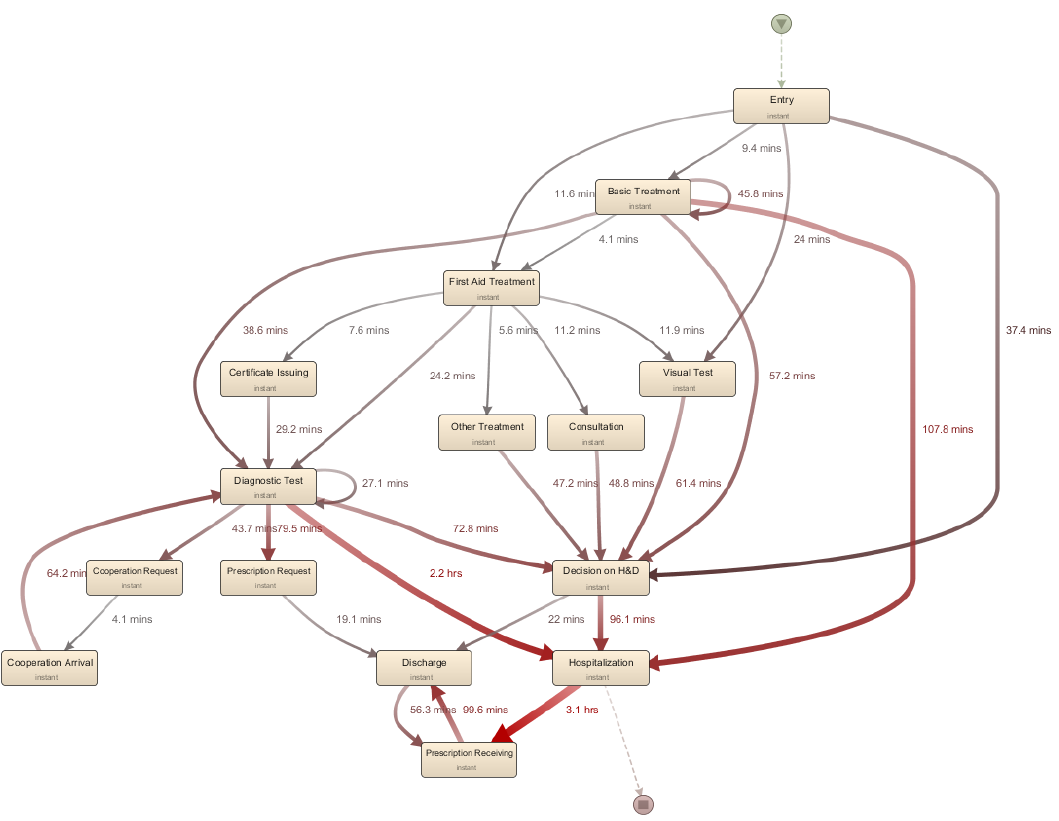
Figure 3. The time-related analysis result with the process